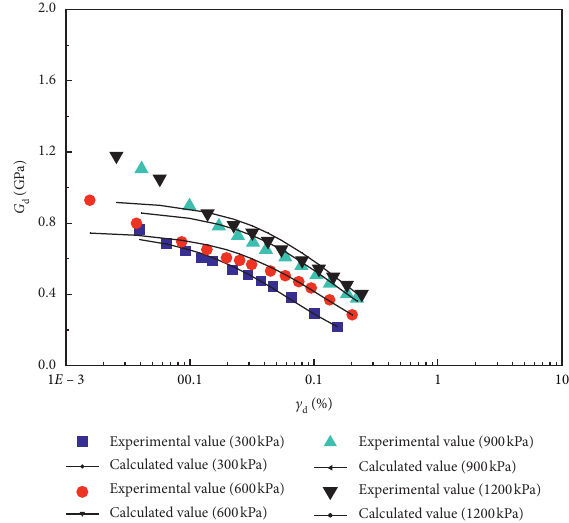
Figure 10: Relation between G max cementing agent contents.